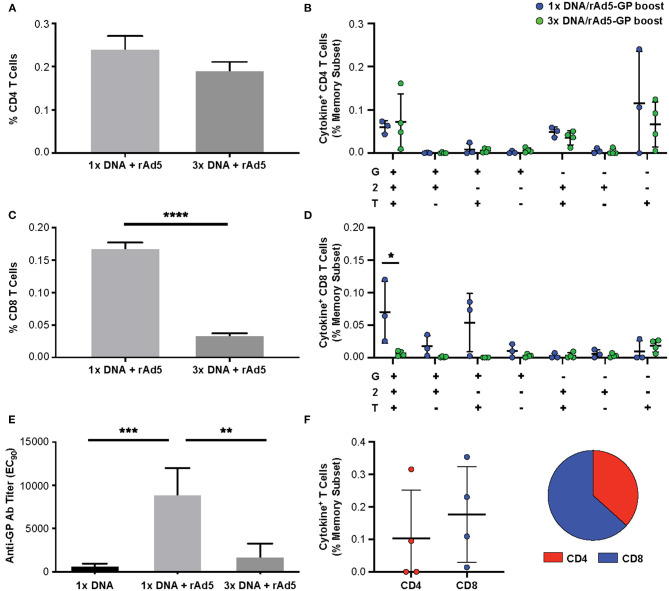
Durability of the immune response following DNA prime rAd5-GP boost. Cynomolgus macaques were primed with plasmid vectors encoding GP(Z) and GP(S/G) one or three times. Eight weeks after the last DNA immunization 4 NHP's from each group were boosted with 1011 PFU of rAd5-GP vaccine. Blood sampling for anti-GP antibody and T-cell analysis were collected 130–160 weeks after the rAd5-GP boost, and at 159 weeks from four animals which received only a single DNA prime immunization without a boost. PBMCs were stimulated with EBOV GP peptides. The magnitude of antigen-specific cytokine response and pattern of CD4+
(A,B) and CD8+
(C,D) T-cells (G:IFNγ, T:TNFa, and 2:IL-2). (E) Specific anti-GP antibody titers were measured using ELISA. (F) Ebola GP specific CD4+ and CD8+ T-cells after rAd5 GP boost that was given 159 weeks after a single DNA prime. Statistical analysis between two groups was performed using an unpaired student's t-test, comparison between more than two groups were performed using a one-way ANOVA with Tukey's post hoc test; *p < 0.05, **p < 0.01, ***p < 0.001,****p < 0.0001; mean ± standard deviation shown.